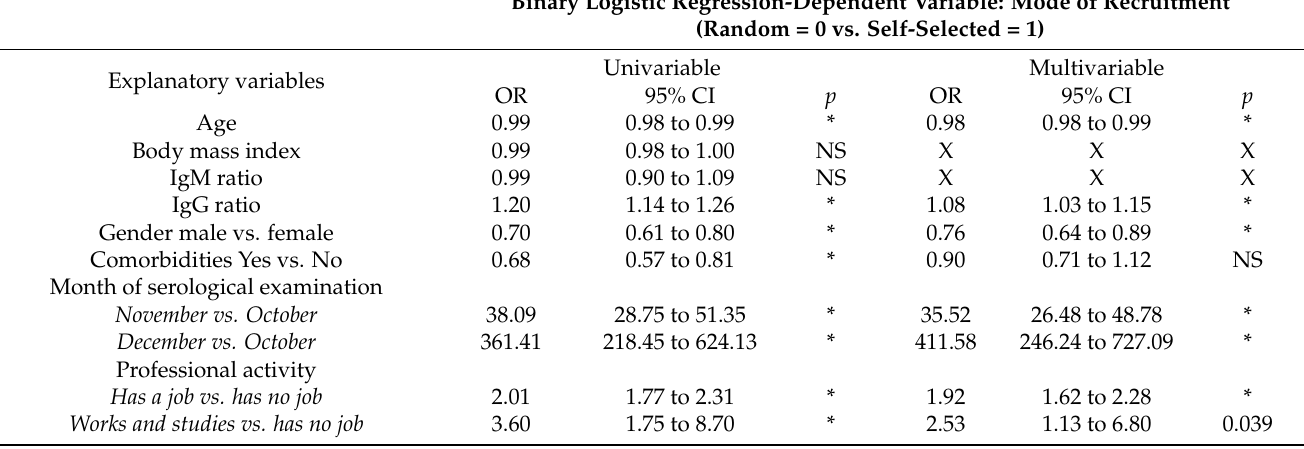
Table 5. Characteristics of the respondents in univariate analyses and multivariate binary logistics regression model in relation to the recruitment mode as dependent variable. Binary Logistic Regression-Dependent Variable: Mode of Recruitment (Random = 0 vs. Self-Selected =